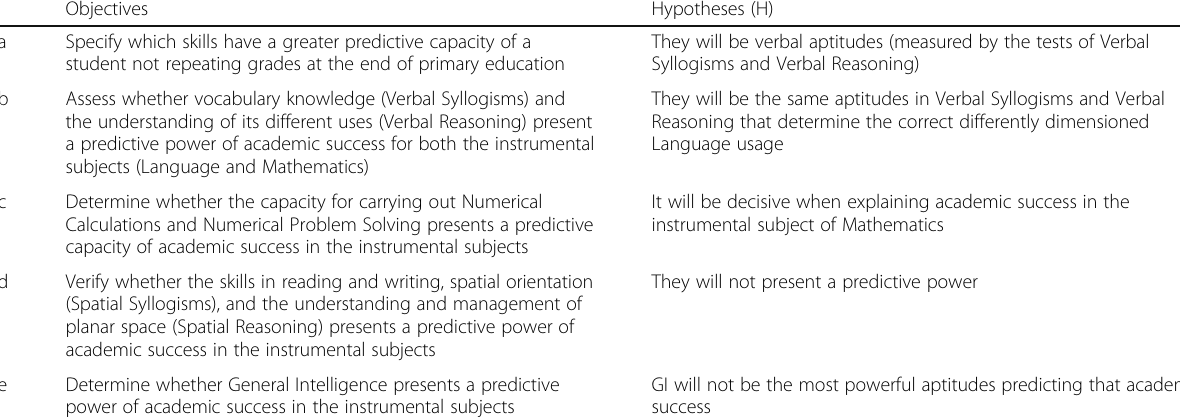
Table 1 Objectives and hypotheses of the study